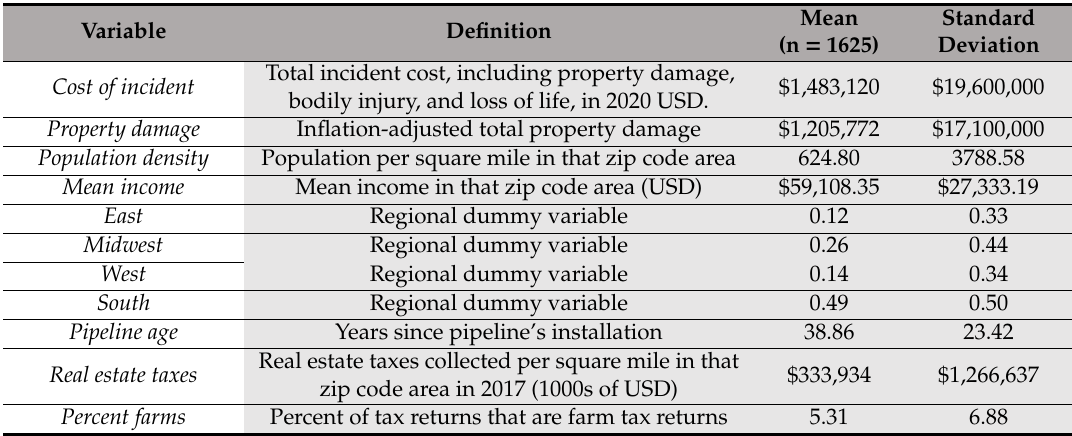
Table 1. Variable definitions and summary